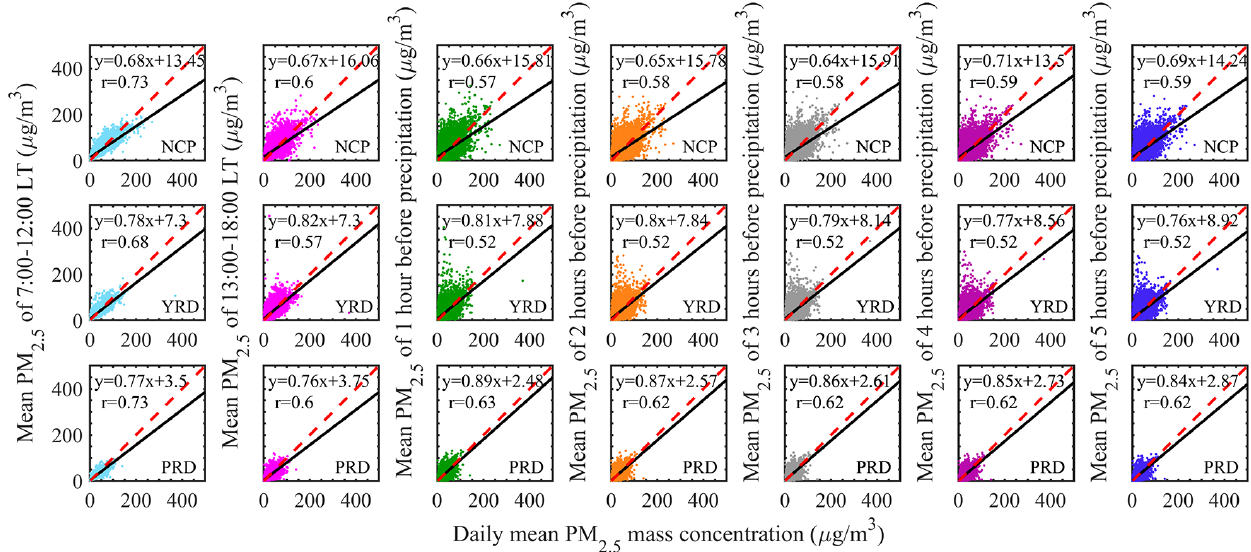
Figure 2. The relationships between the daily mean PM 2 . 5 mass concentration (µgm − 3 ) and the mean PM 2 . 5 mass concentration of 07:00– 12:00LT (azure, the first column), 13:00–18:00LT (roseo, the second column), 1h before precipitation (green, the third column), 2h before precipitation (orange, the fourth column), 3h before precipitation (grey, the fifth column), 4h before precipitation (purple, the sixth column), and 5h before precipitation (blue, the seventh column) in June–August from 2015 to 2020 over the North China Plain (NCP, the first row), Yangtze River Delta (YRD, the second row), and Pearl River Delta (PRD, the third